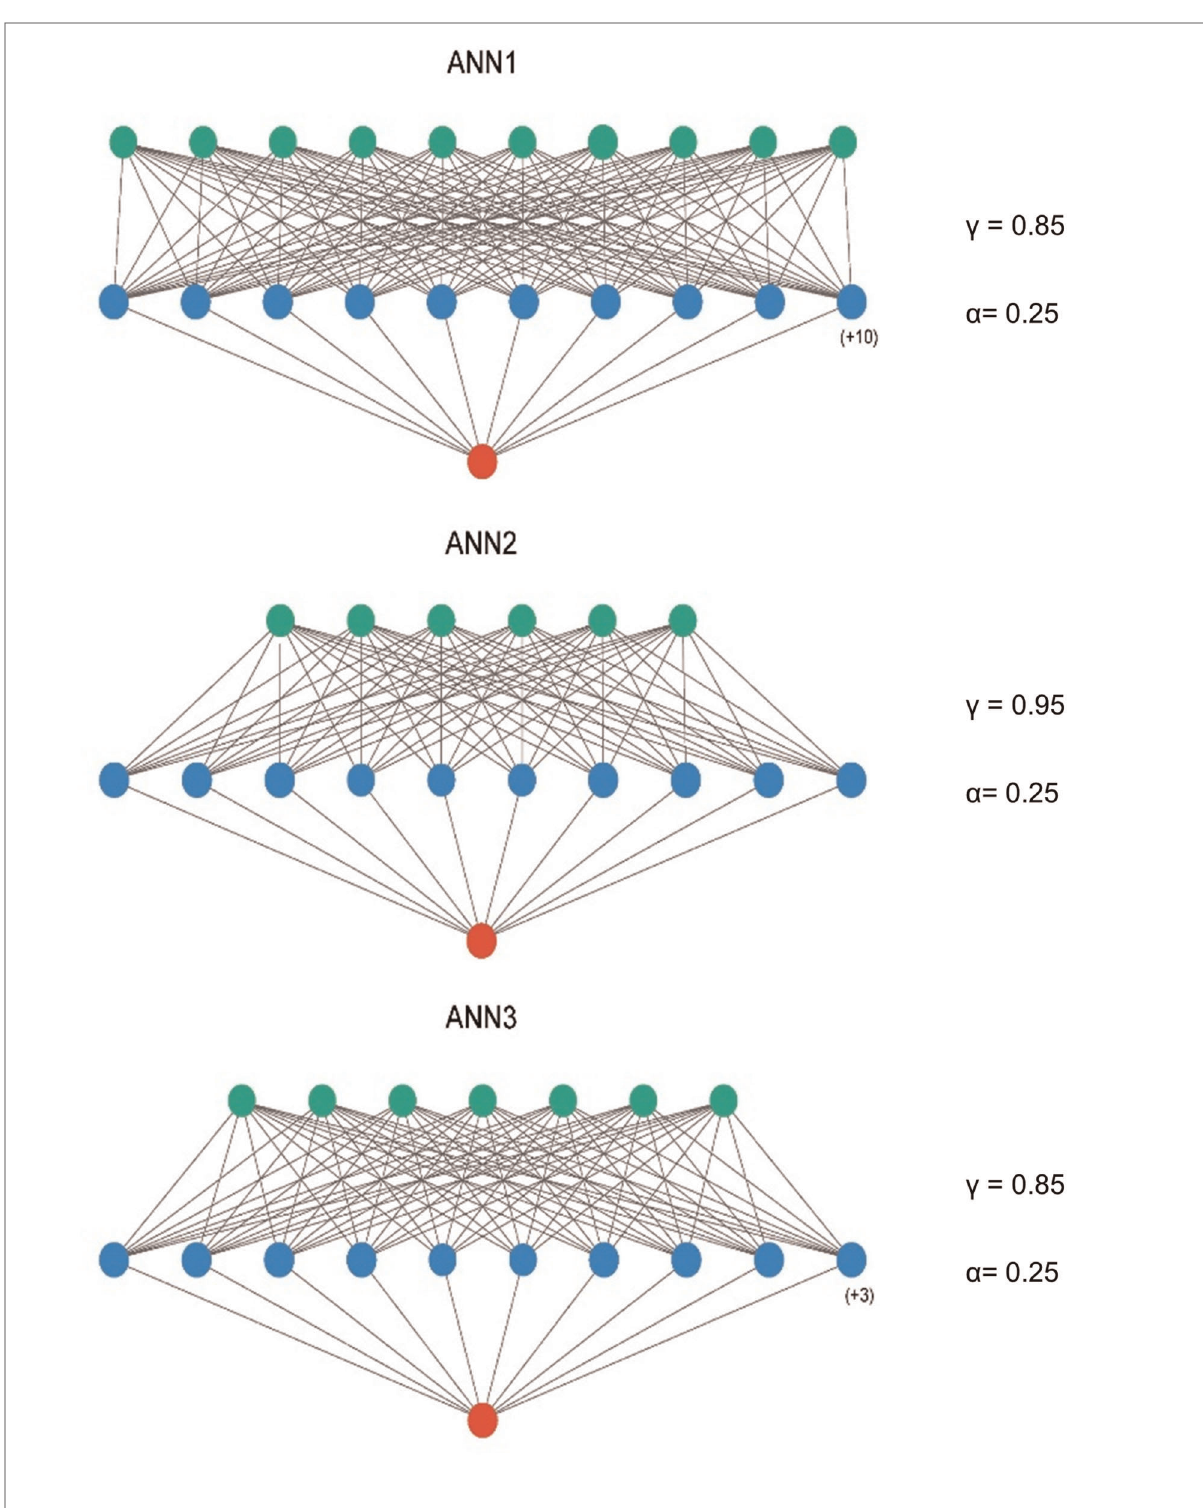
FIGURE 2 ANN model architectures – input layer=green, hidden layer=blue, output layer=red. A ReLu activation was used in the input and hidden layers and a sigmoid activation function in the output layer. ANN1 – Inclusive Model. ANN2 – Parsimonious Model, ANN3 – AIC Model. Figure compiled using ann_visualizer